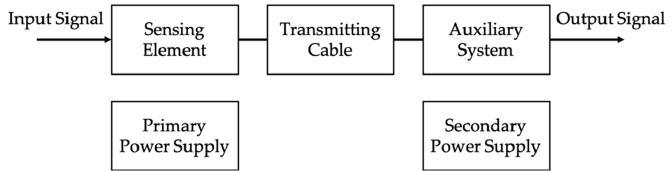
Figure 1. Generic block diagram of a single-phase Low-Power Instrument Transformers (LPIT) (from [2]).